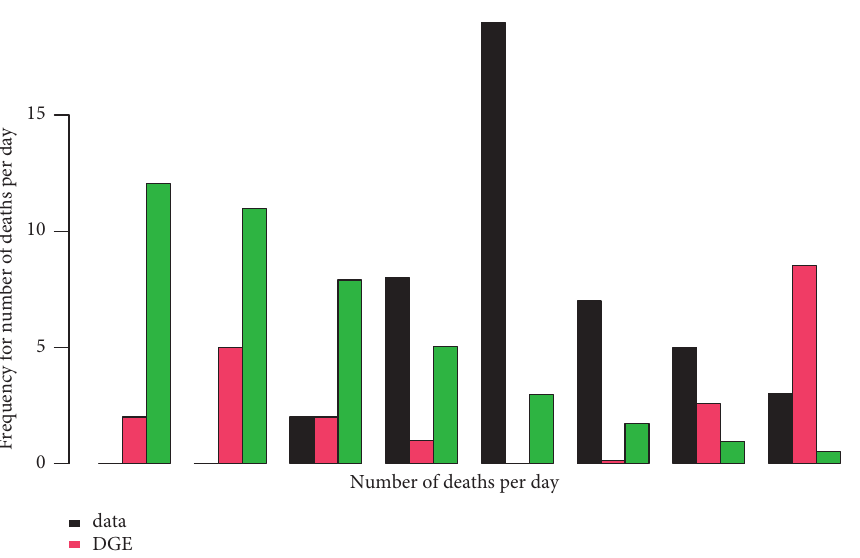
Figure 4: Graphical plots for the expected frequencies and the data using the PMF of different two-parameter distributions, where the x -axis represents the number of deaths per day and the y -axis represents the frequency for this